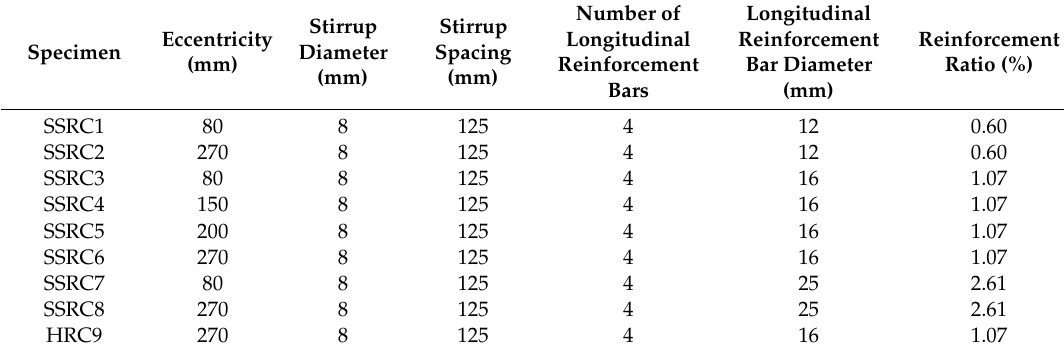
Table 2. Specimen